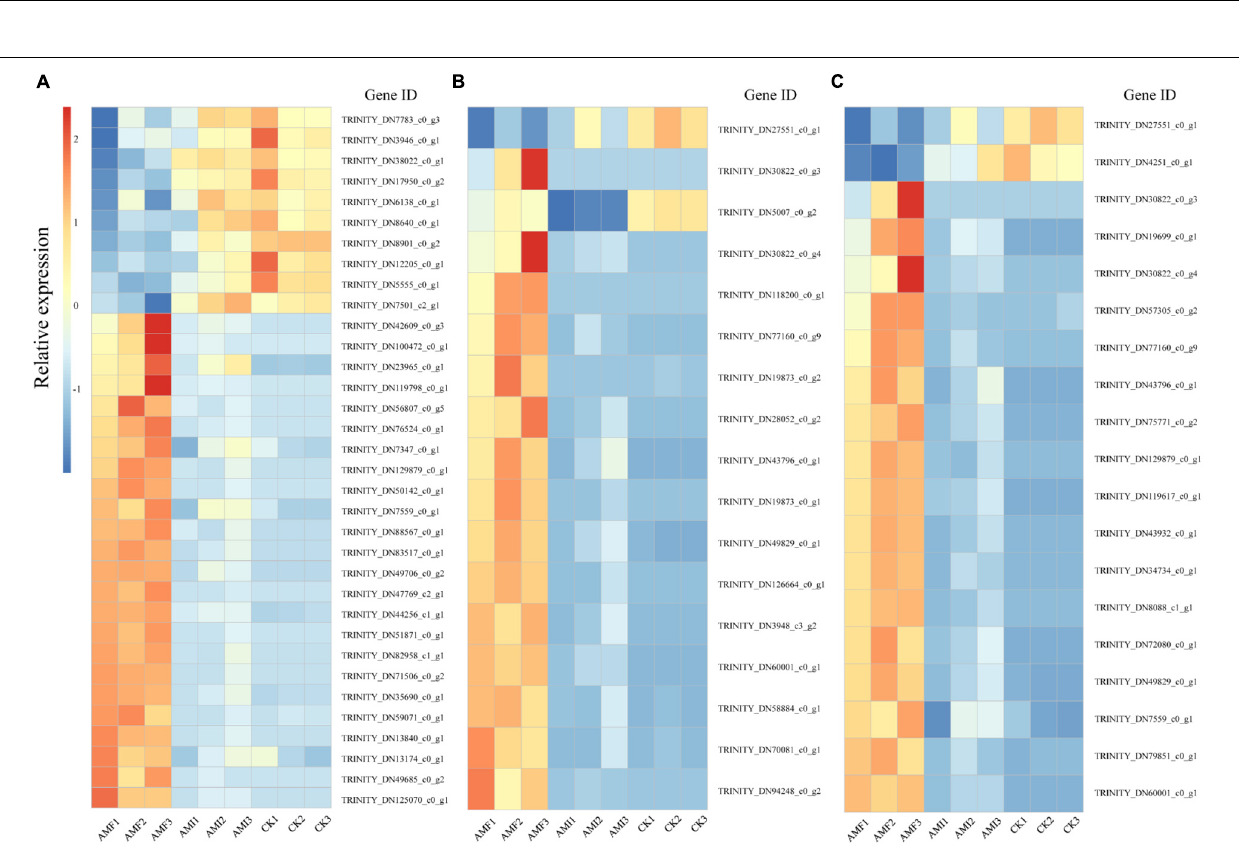
FIGURE 4 | The Kyoto Encyclopedia of Genes and Genomes (KEGG) pathway enrichment analyses of the AM-induced genes upregulated (A) or downregulated (B) by indigenous microorganisms. The x -axis indicates the rich factors of pathways. The y -axis indicates various KEGG pathways. The size of the bubble indicates the number of genes enriched in this pathway. The color of the bubble indicates the significant degree of enrichment.